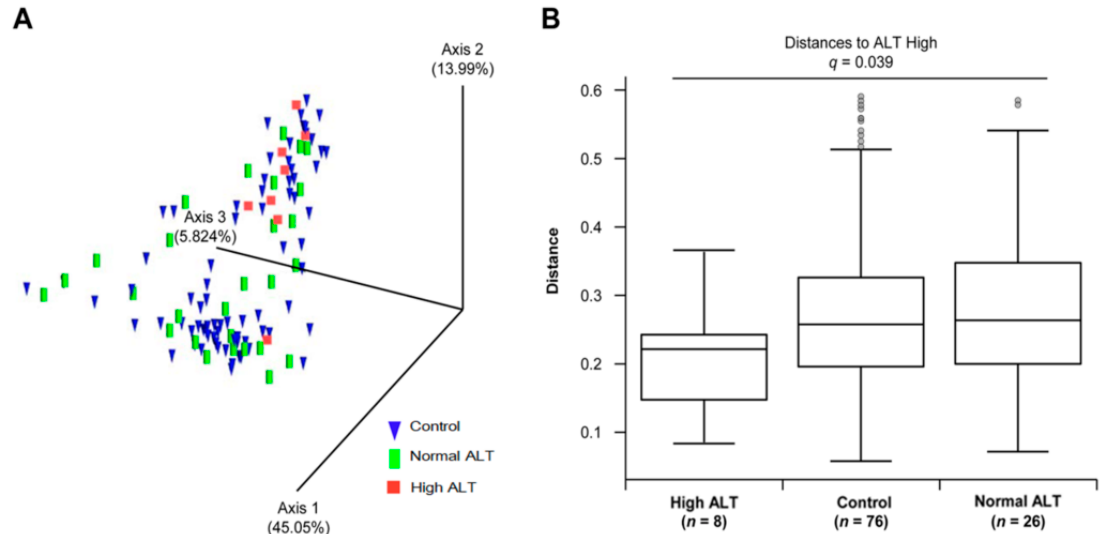
Figure 3. Comparison of beta-diversity between sample groups. ( A ) Principal coordinates analysis (PCoA) plots according to weighted UniFrac. Control: blue, normal ALT: green, high ALT: red. ( B ) Comparison of weighted UniFrac distant matrices between each group. Normal ALT distance to high ALT was significant ( q = 0.039). The values of q were calculated by Benjamini–Hochberg correction (FDR).